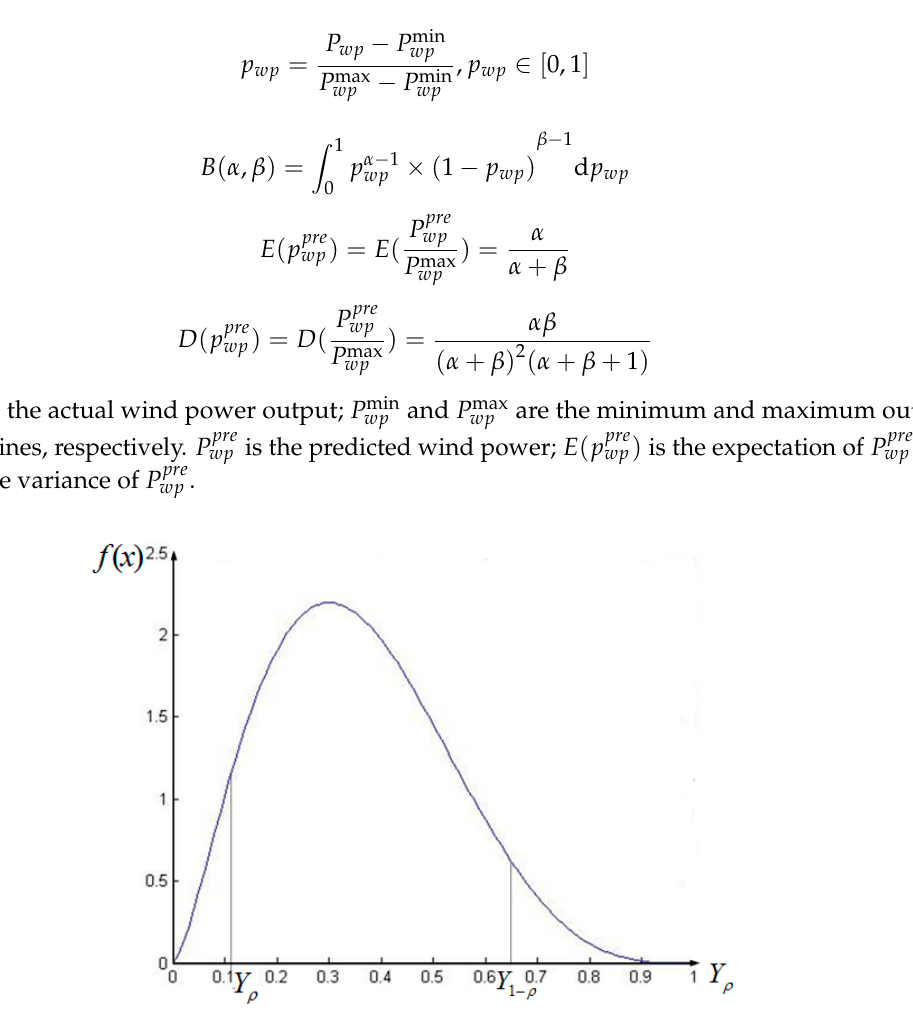
Figure 6. Beta distribution curve.